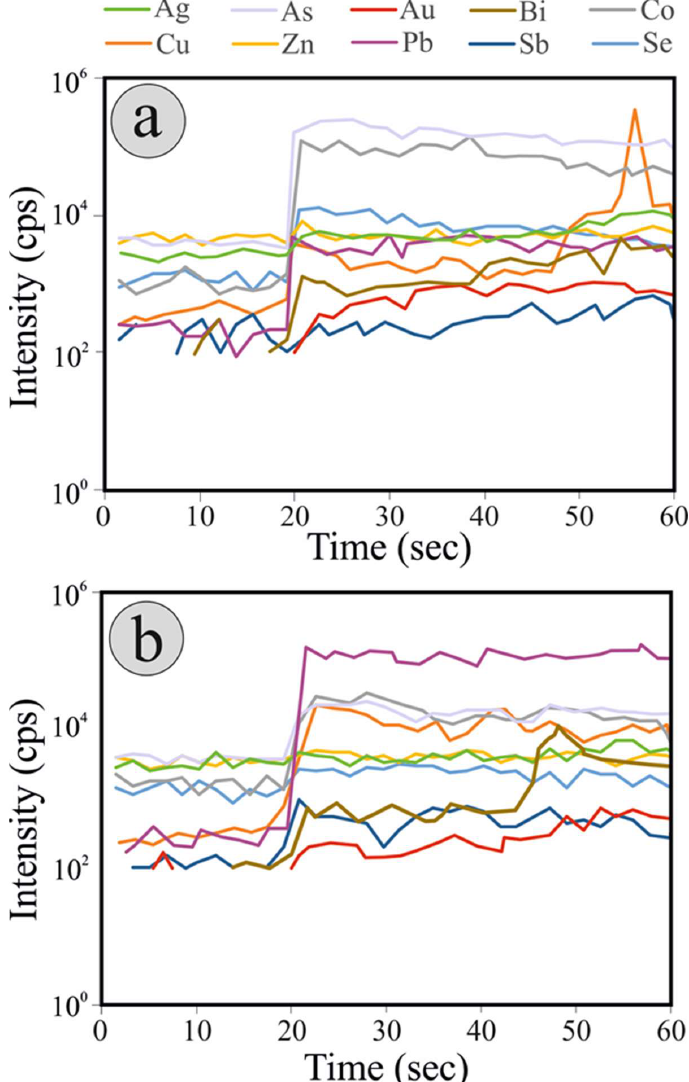
Figure 11. Time-resolved laser ablation ICP-MS depth profiles of Ag, As, Au, Bi, Co, Cu, Zn, Pb, Sb, and Se in pyrite. ( a ) D-type vein, (sample KMPR66). Most of the elements are characterized by homogeneous distribution, as expressed by their flat concentration patterns. The spiky pattern of Cu indicates the presence of submicroscopic inclusions (chalcopyrite); ( b ) E-type vein, (sample KMPR53). All elements but Bi show homogeneous distribution in pyrite. The spiky pattern of Bi is indicative of the presence of a submicroscopic, Bi-bearing phase (bismuthinite?).